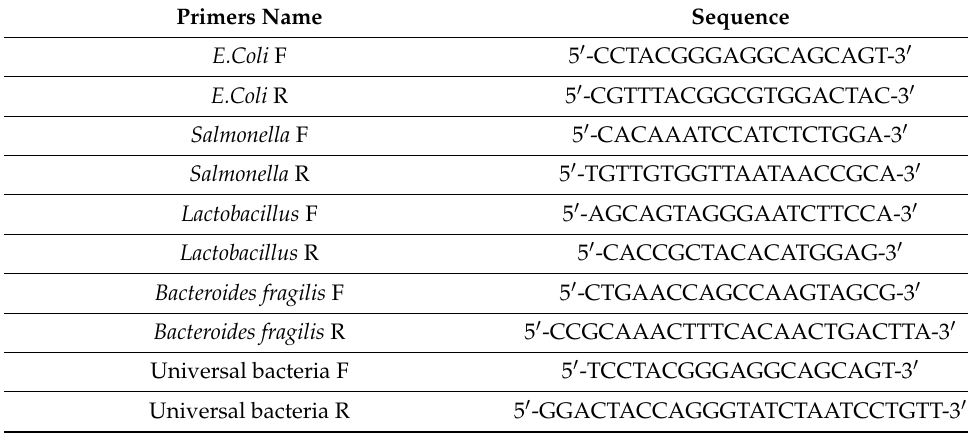
Table 1. Real-time PCR